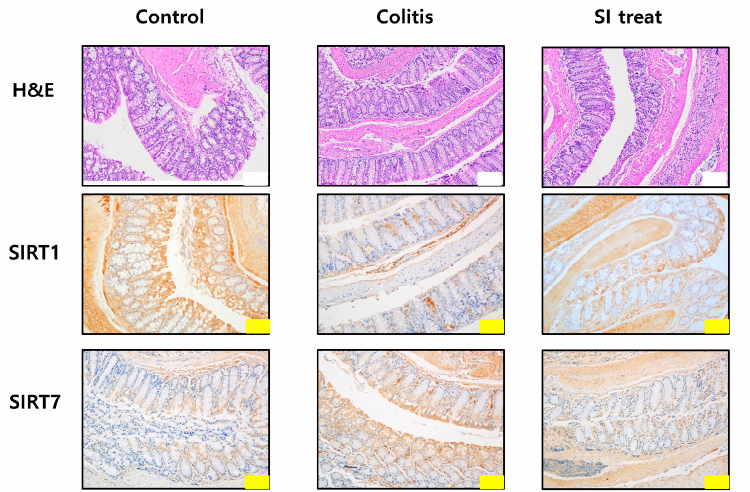
Figure 3. Microscopic analysis of the colonic mucosa in mice. Histological analysis of the colonic mucosa of mice in the control, colitis, and SI-treated groups after hematoxylin and eosin staining. Immunohistochemical staining of SIRT1 and SIRT7 in the colonic mucosa. Yellow scale bar = 100 µ m, white scale bar = 200 μ m.